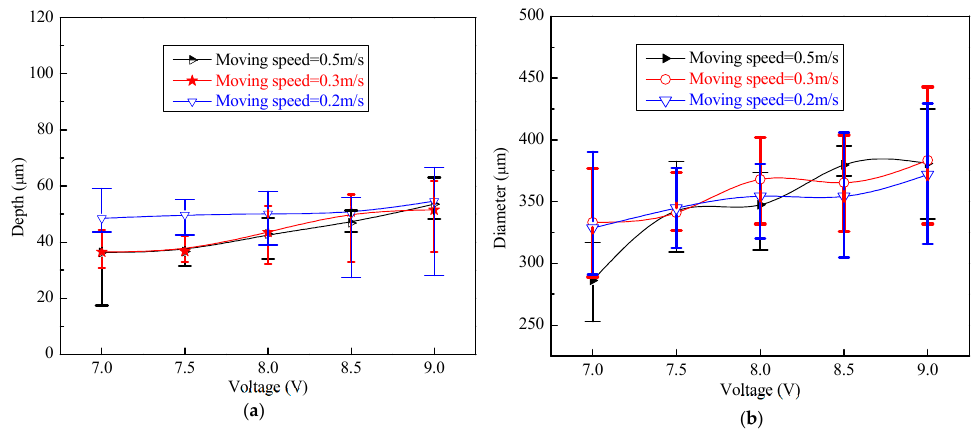
Figure 14. Dimensions of micro ‐ dimples machined under different single ‐ travel moving speeds and with the magnetic field ( a ) depth of micro ‐ dimples ( b ) diameter of micro ‐ dimples.